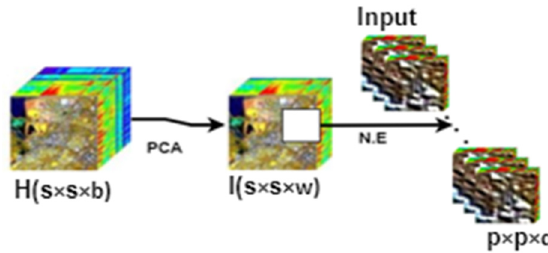
Figure 2. Preprocessing of raw HSI data cube.